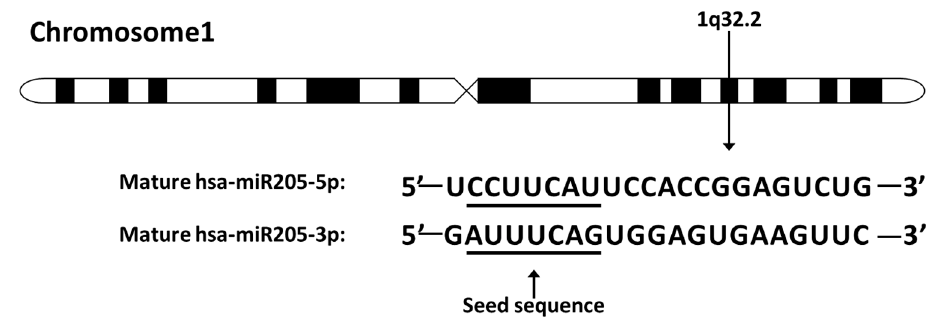
Figure 1. The miR-205 location on chromosome and sequence. MiR-205 locates on human chromosome 1q32.2. The seed sequences of miR-205-5p and miR-205-3p are underlined. The miR-205 discussed in this review refers to miR-205-5p.